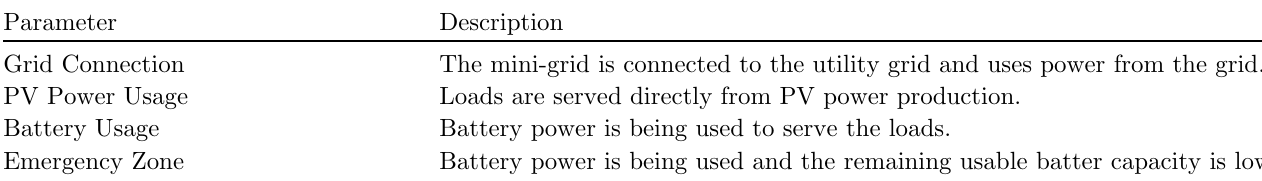
Table 1. Mini-grid status parameters.